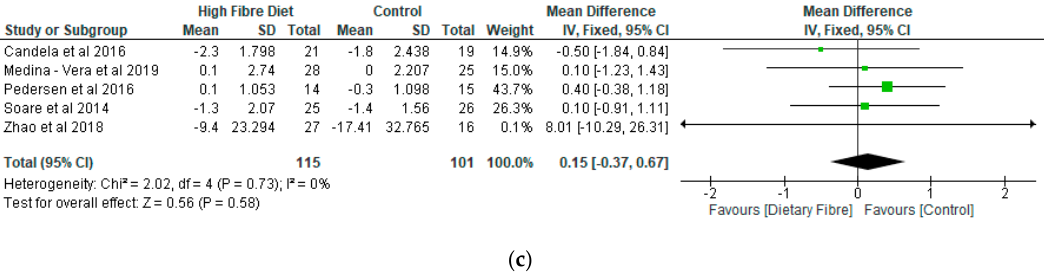
Figure 5. ( a ) The effect of dietary fibre on fasting blood glucose (mmols/L). ( b ) The effect of dietary fibre on glycated haemoglobin (%). ( c ) The effect of dietary fibre on homeostatic model assessment of insulin resistance (HOMA-IR).